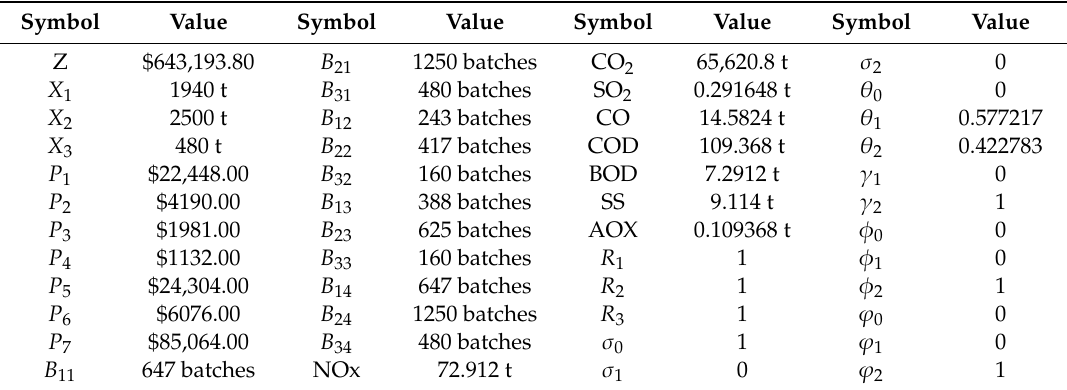
Table 2. The optimal solution of numerical example